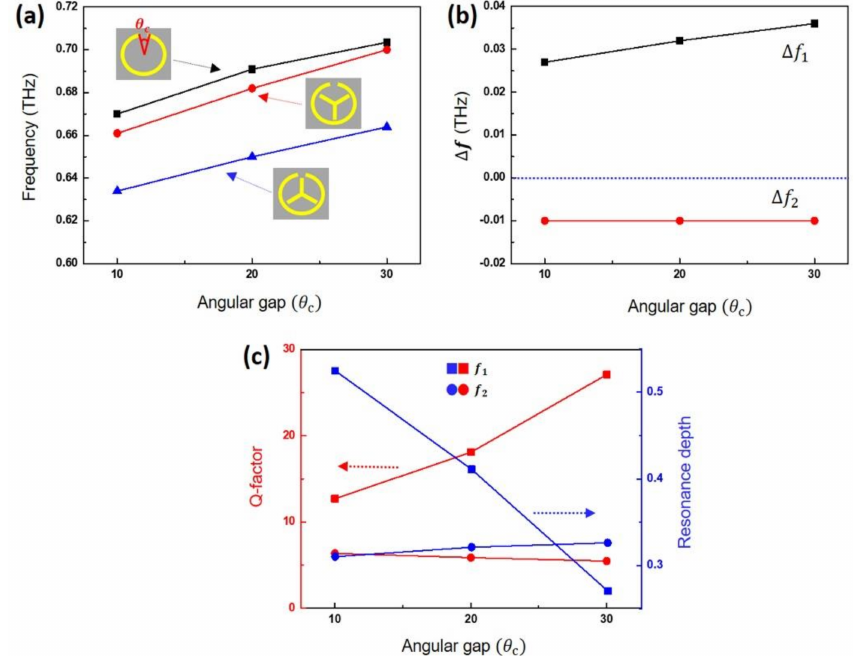
Figure 4. ( a ) Resonant frequencies of the second-order LC resonance obtained at three samples of the C-shaped meta-atoms and two states of meta-rotamers. ( b ) Frequency shift of the second-order LC resonance ( ∆ f 1 ) and dipole resonance ( ∆ f 2 ) as a function of angular gap θ c . ( c ) Q-factor (red squares and circles, left scale) and resonance depth (blue squares and circles, right scale) for the two resonances, f 1 (blue and red squares) and f 2 (red and blue circles),